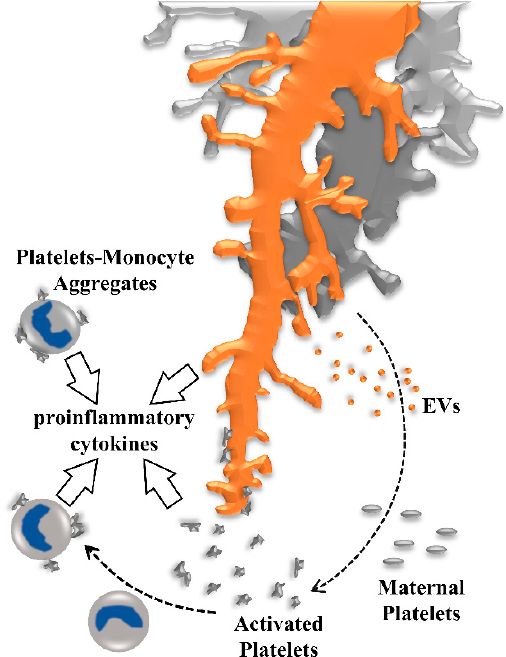
Figure 4. Activation of maternal platelets contributes to a proinflammatory environment in human placenta. Maternal platelets are activated by their passage through the intervillous space by local stasis, turbulences, or damage of the syncytiotrophoblast, moreover, platelets are activated by syncytiotrophoblast-derived extracellular vesicles (EVs) which are shed from the syncytiotrophoblast layer in response to oxidative and inflammatory stress. Activated platelets release ATP and provoke inflammasome activation in placental villi, leading to the release of proinflammatory cytokines into the intervillous space. Adhesion of activated platelets to the villous surface contributes to deposition of perivillous fibrin-type fibrinoids, which has been suggested as an important regulator of intervillous hemodynamics, and in shaping the microanatomy of villous trees. As soon as utero-placental blood flow is fully established, formation of platelet-monocyte aggregates induces monocytes to release proinflammatory cytokines and the antiangiogenic soluble fms-like tyrosine kinase (sFlt-1).